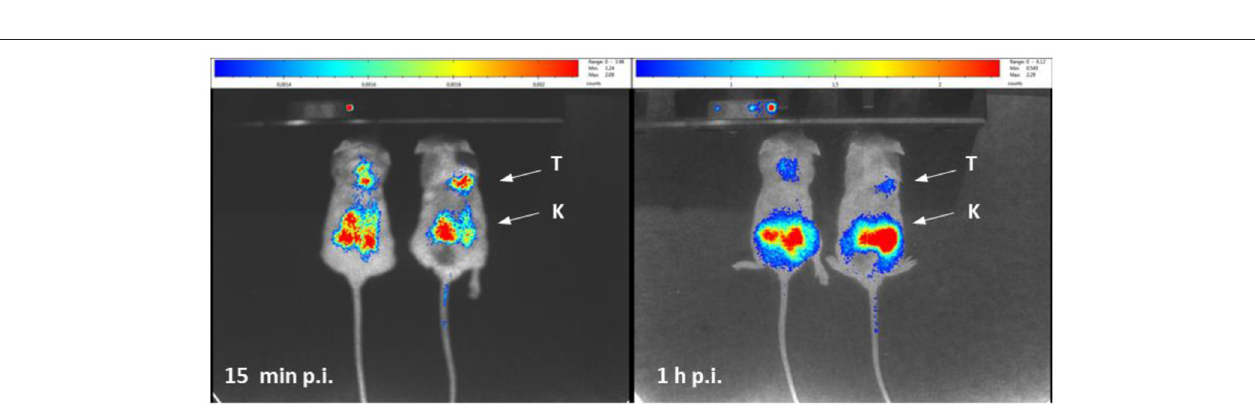
FIGURE 3 | Cerenkov luminescence images in the top image at different time points (15min, 1 and 2h) of PC3 tumor-bearing mice administered with [ 90 Y]Y-DOTA-Tz [White arrows indicate the tumor (T) and kidneys (K)]. In the bottom image, the biodistribution data for [ 90 Y]Y-DOTA-Tz in PC3 xenografts bearing mice, expressed as % I.D./g of organ (mean ± S.D., n = 4).